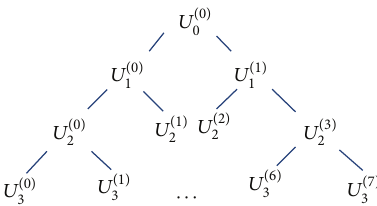
Figure 4: Three-layer decomposition diagram of wavelet packet.